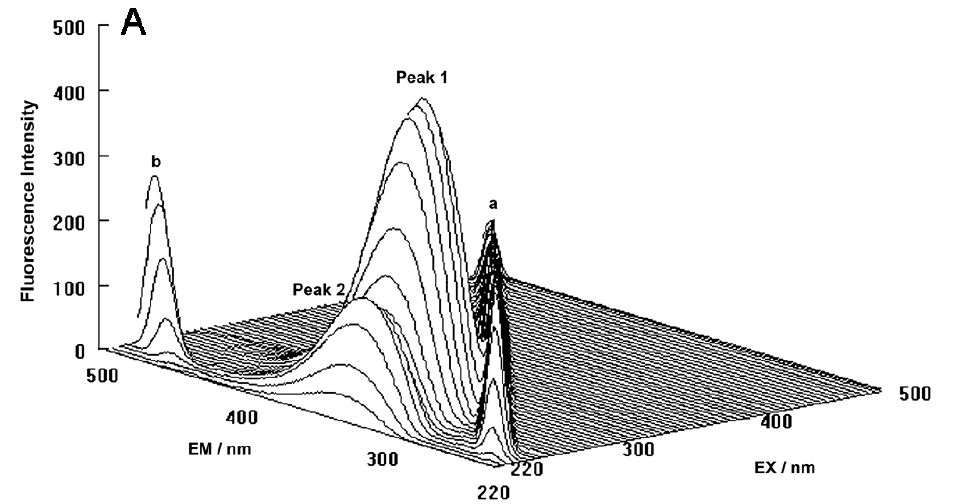
Figure 9. ( A ) Three-dimensional fluorescence spectra of hTf; ( B ) Three-dimensional fluorescence spectra of the hTf-ROP system; ( C ) Three-dimensional fluorescence spectra of the hTf-ASA system; ( D ) Three-dimensional fluorescence spectra of the hTf-ROP-ASA system. All experiments were performed under identical conditions, [hTf] = 3.8 × 10 − 3 mM, [ROP] = 7.27 × 10 − 5 mM, [ASA] = 4.54 × 10 − 3 mM, pH = 7.4 and T = 298